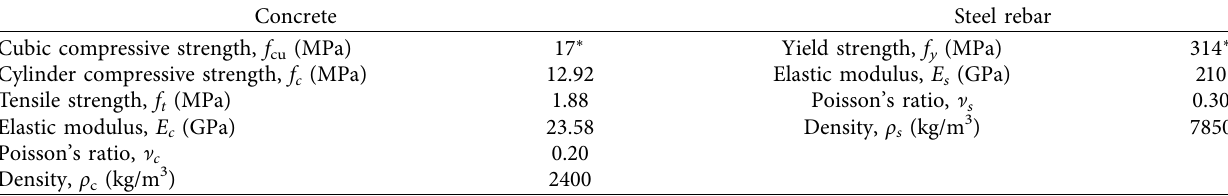
Table 2: Mechanical and physical properties of concrete and steel